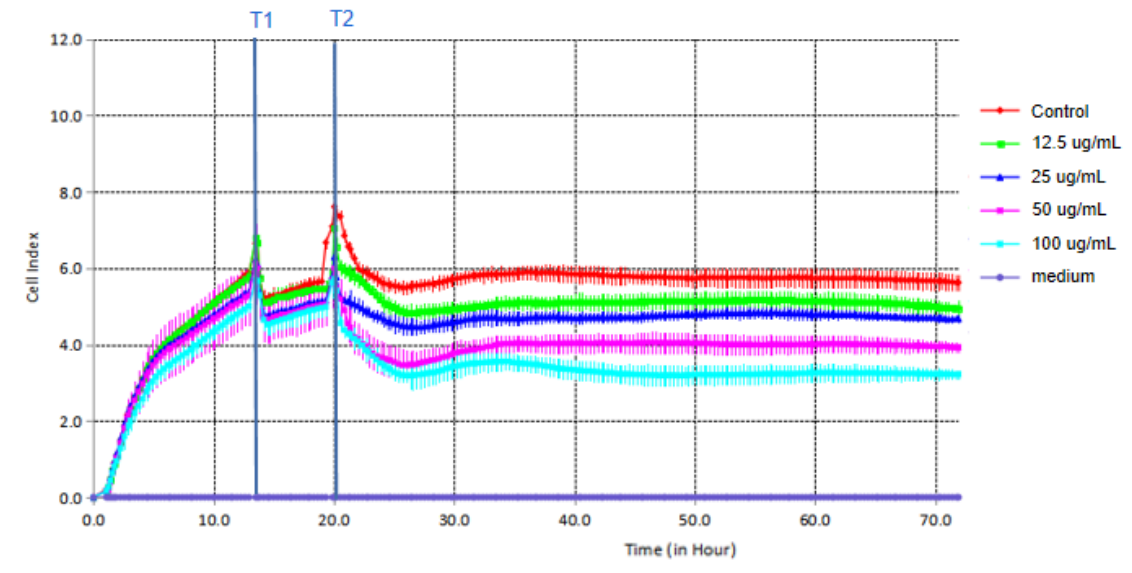
Fig. 3. Cell growth curve of BMEC induced by CGA extract by RTCA assay Note : The T1-T2 time period represents the length of